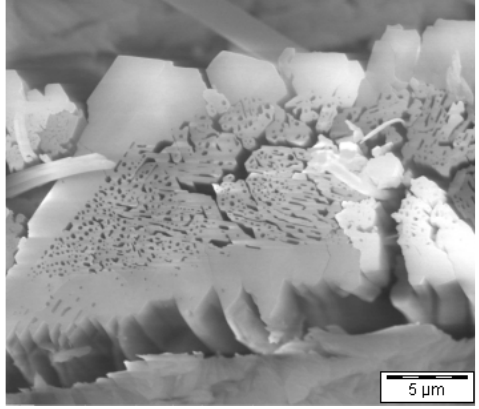
Figure 12. α -HH formed in gypsum along c-axis.